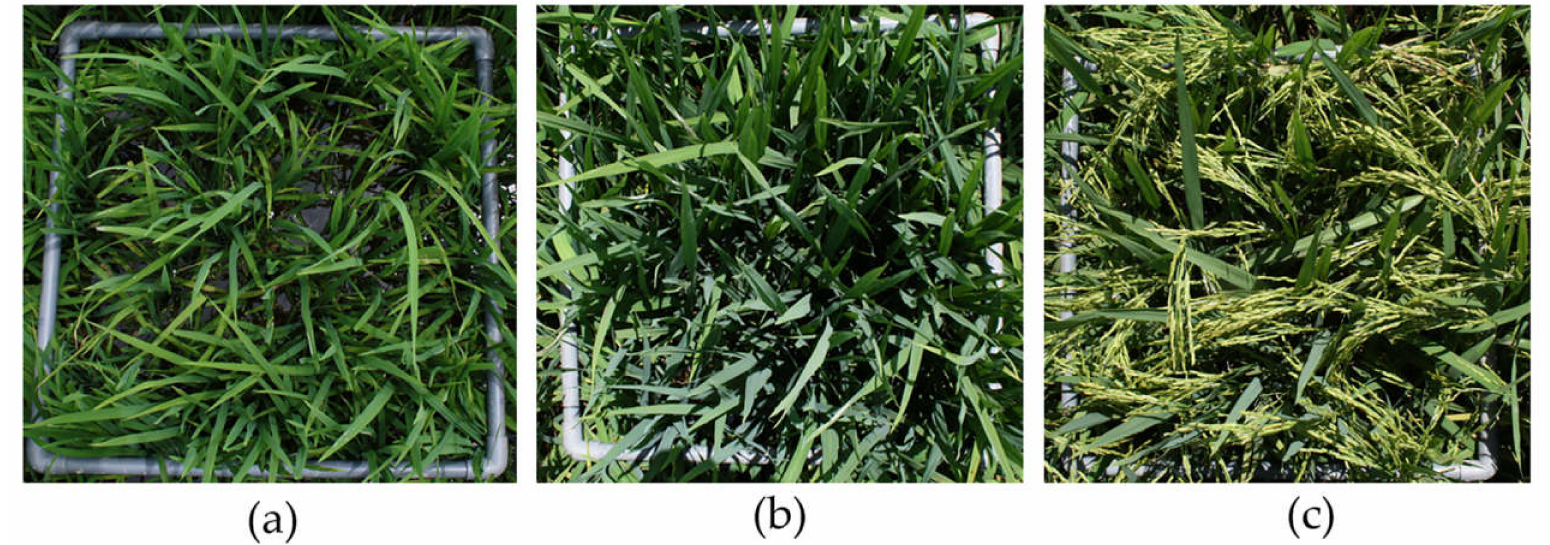
Figure 9. Paddy crop conditions at ( a ) tillering, ( b ) booting and ( c ) milking